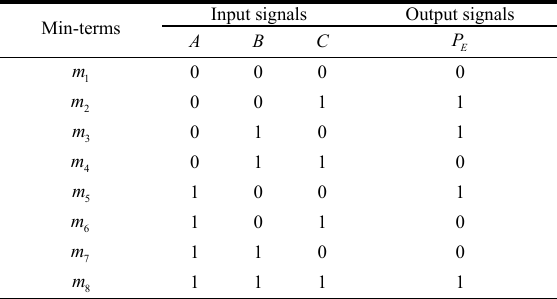
Fig. 4 Schematic diagram of even parity generator. Table 1 Truth table of even parity